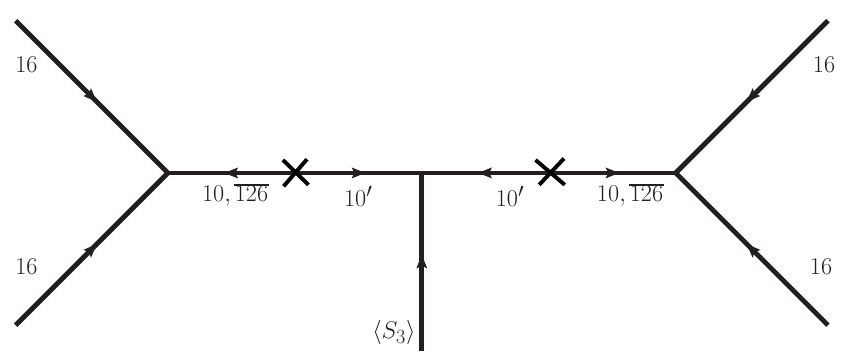
Figure 1 . Feynman diagram responsible for proton decay in our theory. This diagram contains four di(cid:11)erent diagrams involving Yukawa couplings of color triplet (cid:12)elds from either the 10 H or 126 H Higgs